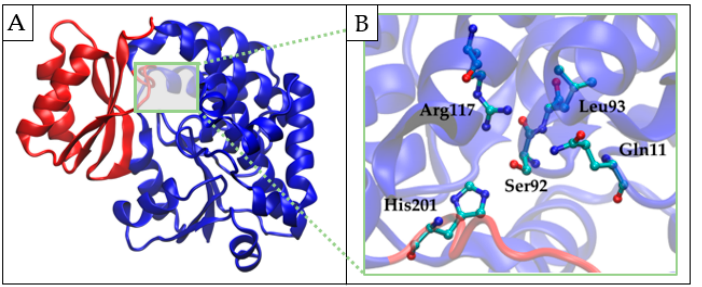
Figure 2. ( A ) Ec FabD apo structure (PDB ID 1MLA). The ferredoxin-like and α / β hydrolase subdo- mains of Ec FabD are coloured in red and blue, respectively. Visual molecular dynamics was used to visualise enzymes and their active sites [32], unless otherwise specified. ( B ) View of the apo active site of Ec FabD (PDB ID 1MLA). This view is focused on the five catalytic residues. The transfer of the malonyl group from malonyl-CoA to ACP occurs in three main steps (Figure 3A ) . First , His201 activates Ser92 through a hydrogen bond and facilitates the nucleophilic attack on the malonyl-CoA thioester I carbonyl. The appearing negative charge on the oxygen atom of malonyl-Ser92 intermediate II is stabilised by the oxyanion hole formed by the main-chain amides of Gln11 and Leu93 [30,31]. The structure of Ec FadD with processed malonyl-CoA reveals that, in the second step, intermediate III covalently binds to Ser92 and forms a bidentate salt bridge between the carboxylate of the malonyl moiety and the guanidinium of Arg117, which is involved in substrate recogni- tion [31]. Orientation of the formed ester bond allows nucleophilic attack by the phospho- pantetheine arm of ACP to obtain IV [31].